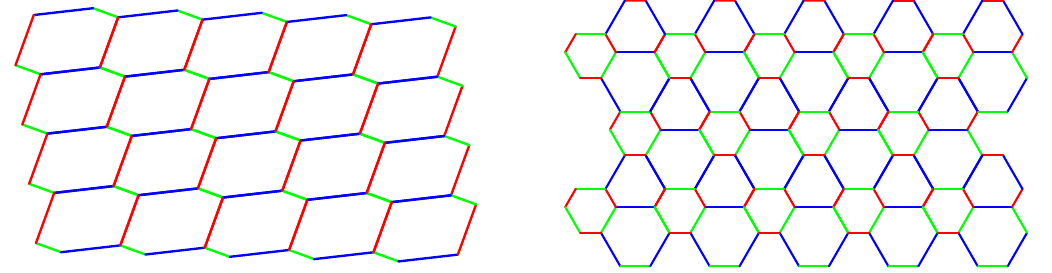
Fig. 44: All hexagons are translations of each other (D).